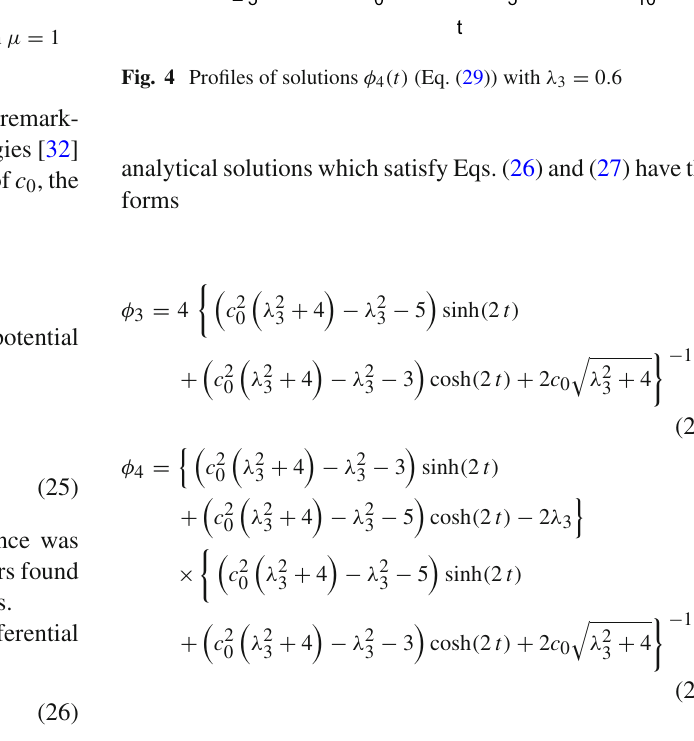
whose profiles are show in Figs. 3 and 4, respectively. It is relevant to point that Fig. 4 unveils the asymmetric two-kink profile when we consider values close to c crit